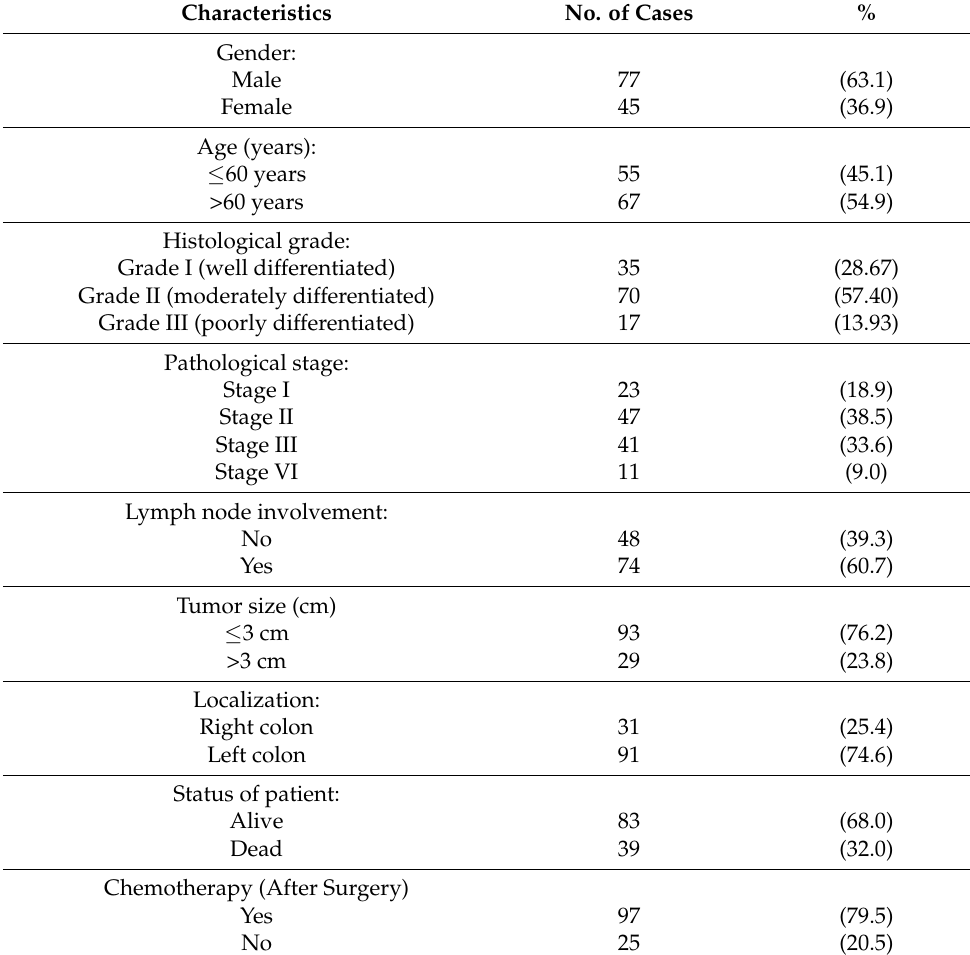
Table 1. Clinicopathological data of the CRC included